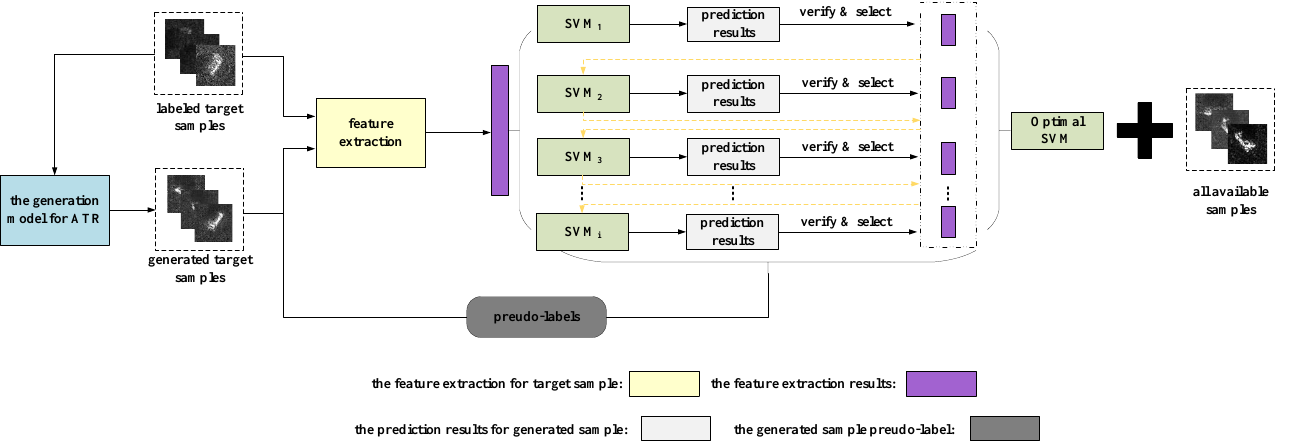
Figure 4. The architecture of the proposed approach. The proposed approach consists of a generation model and a batch of SVMs with differences. The yellow dashed line indicates the proposed filtering process that uses and labels the generated